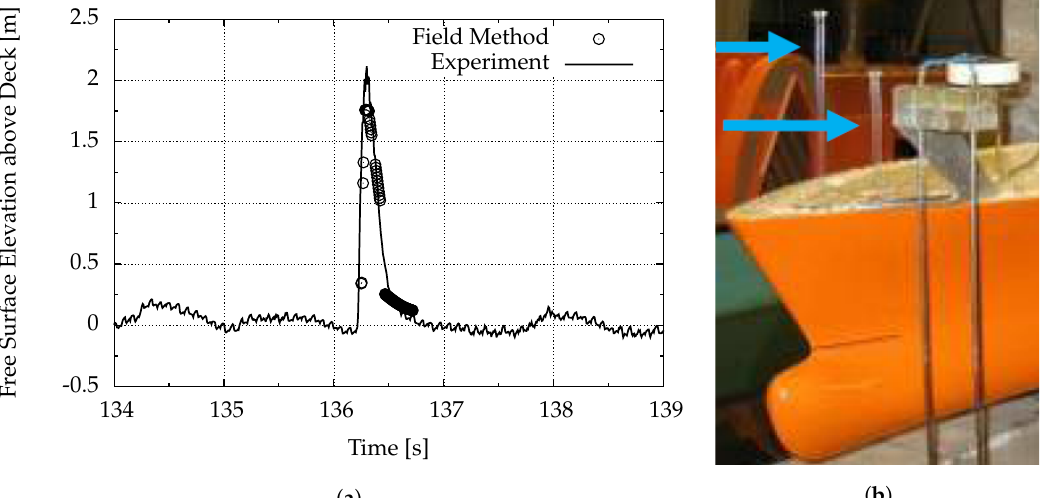
Figure 21. LNG carrier: ( a ) field method computed and measured time histories of free surface elevation above deck and ( b ) wave gauge arrangement on the physical model